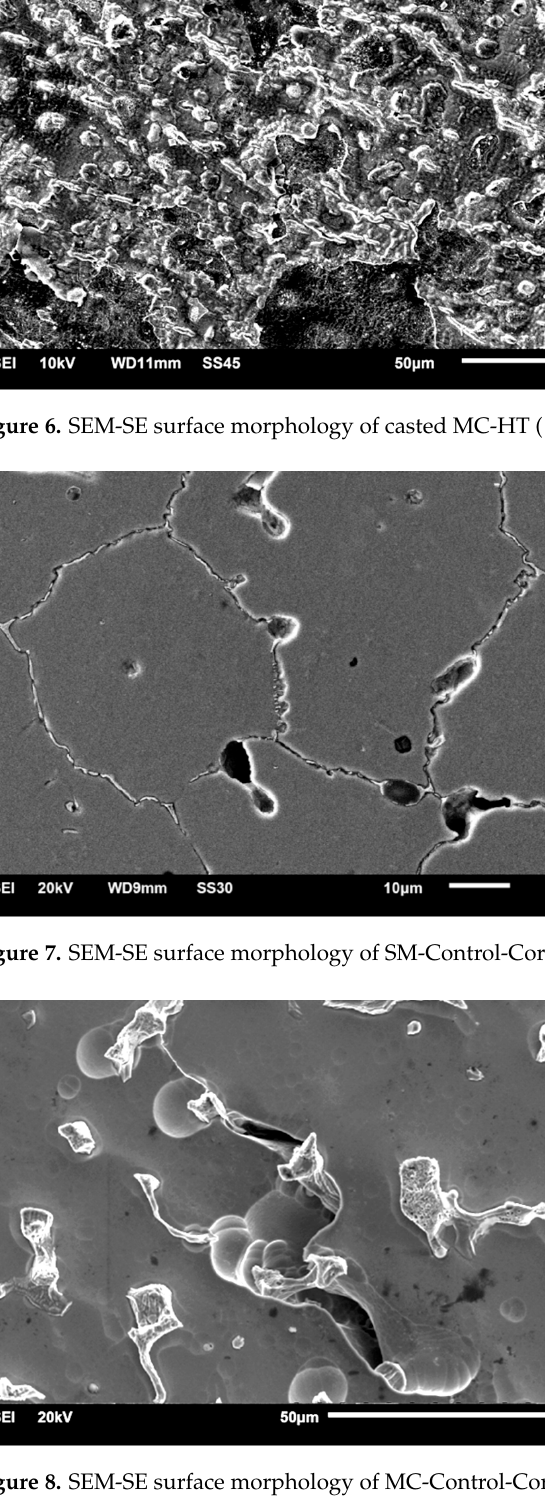
Figure 8. SEM-SE surface morphology of MC-Control-Corr (×1000).